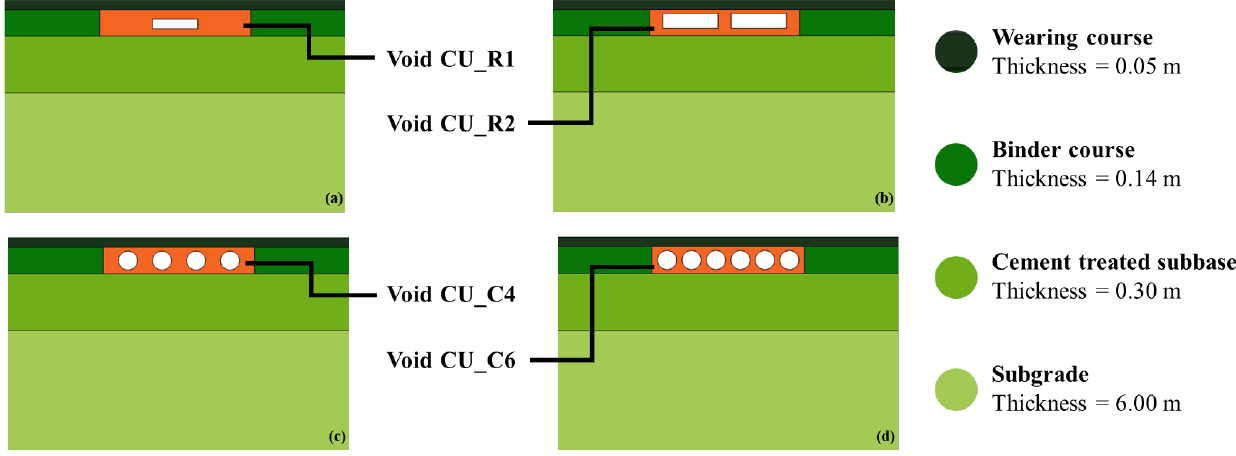
Figure 3. Cross-sectional geometry; ( a ) e-road_void CU_R1; ( b ) e-road_void CU_R2; ( c ) e-road_void CU_C4; ( d ) e-road_void CU_C6. CU_C4; ( d ) e-road_void CU_C6. Table 1. Concrete main characteristics.